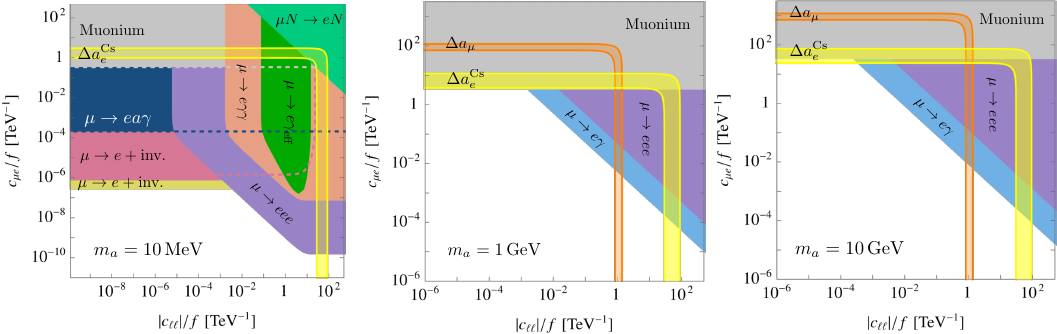
Figure 44 . Bounds on ALP mediated flavor off-diagonal transitions between muons and electrons p with c | [ k E ] 21 | 2 + | [ k e ] 21 | 2 , assuming universal ALP couplings to leptons c ‘‘ ≡ c ee /f = µe ≡ c µµ /f = c ττ /f and m a = 10 MeV, 1 GeV and 10 GeV, respectively. All other Wilson coefficients are set to zero at